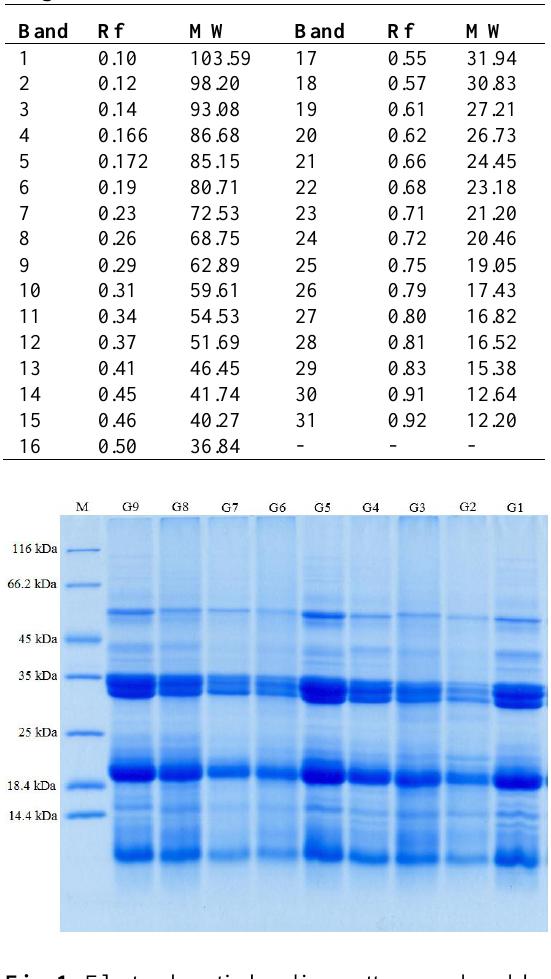
Fig. 1. Electrophoretic banding pattern produced by SDS-PAGE of total seed proteins of Mentha species; M= Molecular weight marker; G1= M.piperita